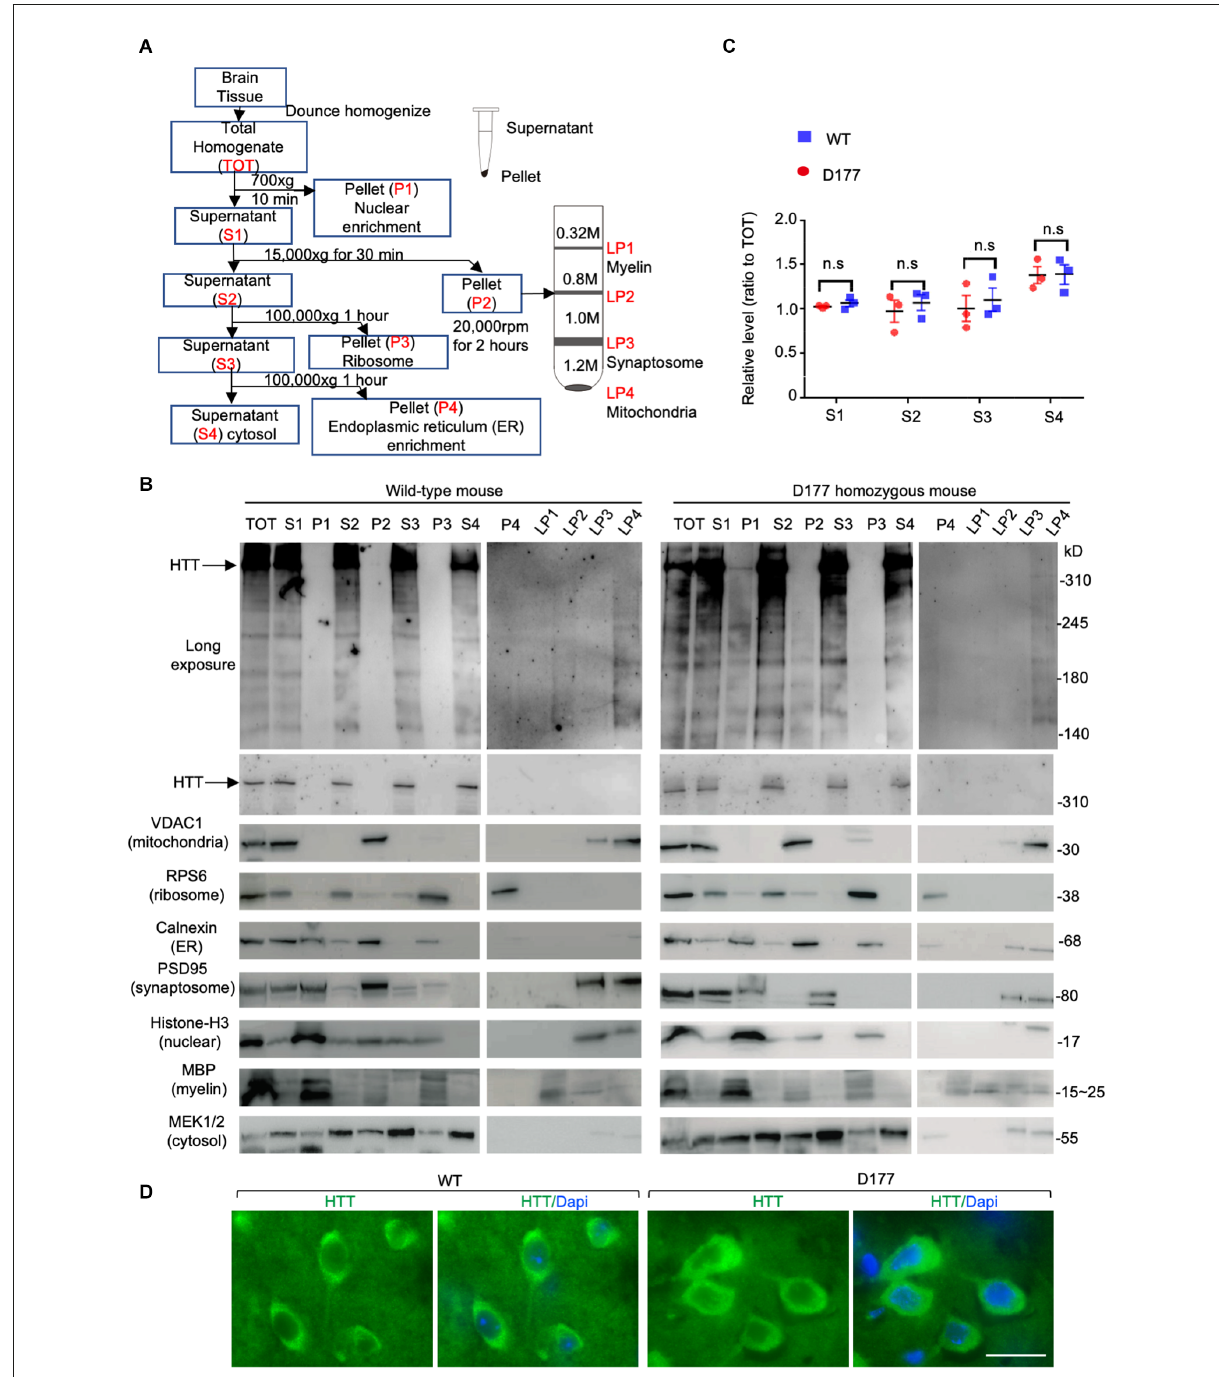
FIGURE2 Subcellular distribution of Htt in D177 homozygous and wild-type mice. (A) A flowchart method to isolate different subcellular fractions. (B) Western blotting analysis of different fractions in the D177 homozygous and wild-type mouse brain, and markers of mitochondria (VDAC1), ribosome (RPS6), ER (Calnexin), synaptosome (PSD95), nuclei (Histone-H3), myelin (MBP), and cytosol (MEK1/2) were examined with their antibodies to confirm the fractionation efficiency. The blots were probed with MAB2166 to detect full-length mouse Htt. Representative Western blots from at least three experiments were presented. Western blots for HTT with short or long exposure time are presented. Other marker proteins are: MEK1/2, mitogen-activated protein kinase 2; Discs Large MAGUK Scaffold Protein 4. (C) Relative HTT expression in supernatant fractions of homozygous D177 and wild-type mice (S1, S2, S3 and S4, ratio to TOT), and the expression of HTT was calculated using ImageJ and the values are ratios to “TOT”, t = 2.692, df = 3, n = 4. ns = not significant. Data were analyzed by GraphPad Prism 7.04. Paired Student’s t -test was used for statistical analysis. Data are presented as mean ± SEM. (D) HTT immunostaining of the brain cortex in 6-month-old WT and homozygous D177 mice. Anti-HTT (D7F7) was used for staining. Scale bar: 20 µ